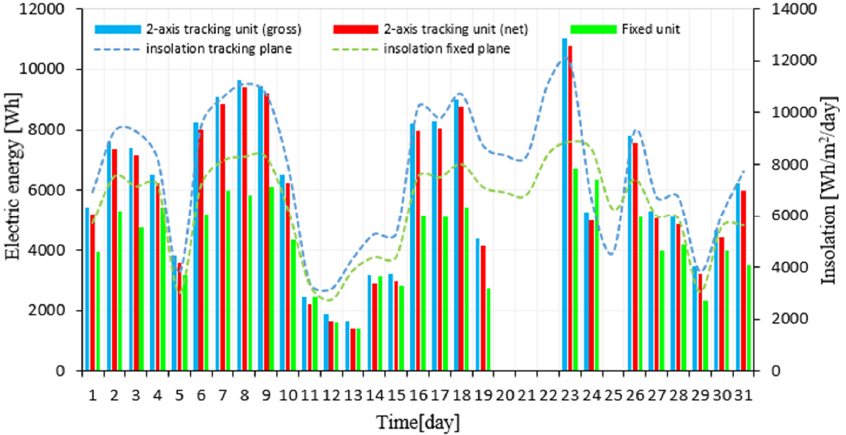
Figure 13. Variability of the electricity production and the determined insolation for photovoltaic modules in the fixed